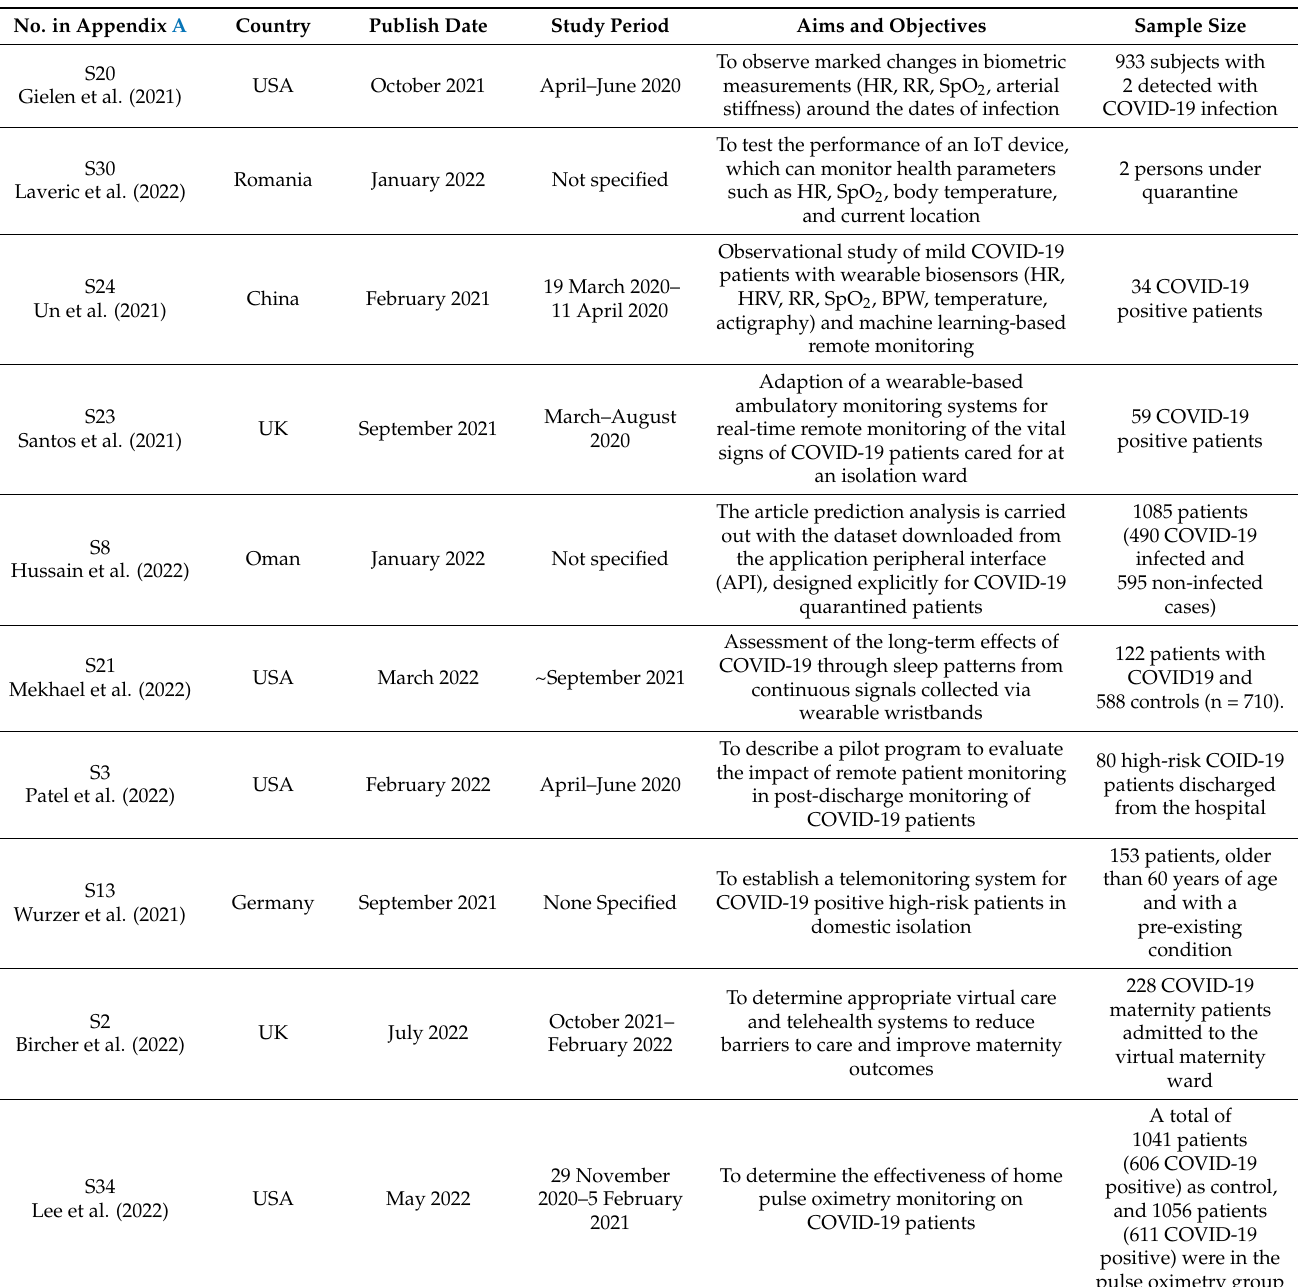
Table 1. List of articles on wearable devices using actual